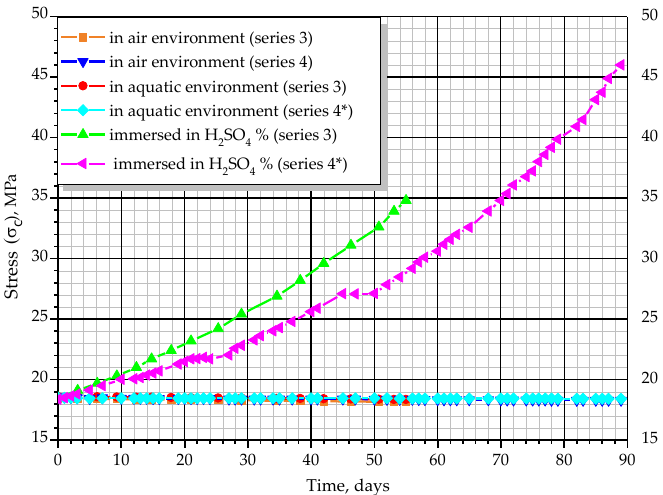
Figure 11. Changes of average stresses of concrete over time.